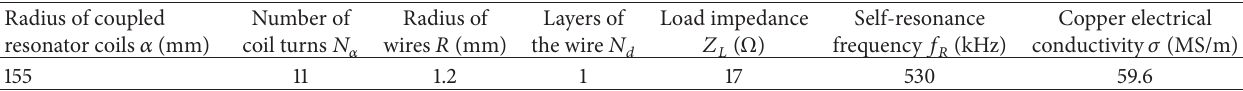
Table 1: Nominal parameter values of the practical coupled resonators.